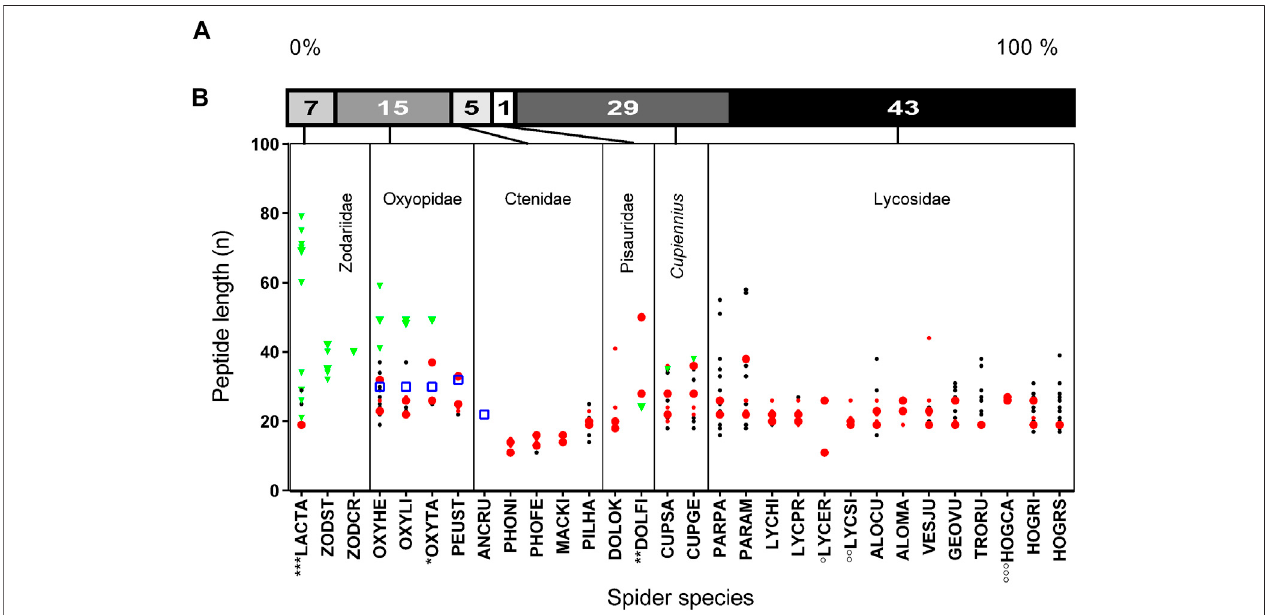
FIGURE 5 | Length and abundance of peptides identi fi ed in simple and binary/complex precursors of different spider families. (A) Relative distribution of identi fi ed LPsindifferentspiderfamilies. (B) Spiderfamilieswiththecorrespondingspecieswherepeptidelengthsaregivenasaminoacidresiduesperpeptide(n).Theabundance ofpeptidesderivedfromsimpleprecursorswithinaspecies isillustrated inbiggreentriangles( > 29%), andsmallgreentriangles( < 29%). PeptidesexhibitingaRanabox- like motif (Dubovskii et al., 2011) are in a blue squares. The abundance of peptides derived from binary/complex precursors within a species is illustrated in big red dots ( > 15%), small red dots ( > 10 – 14%), and black small dots ( < 10%). Data corresponding to *, **, ***, ° , °° , °°° are from UniProtKB ( Supplementary Table S3